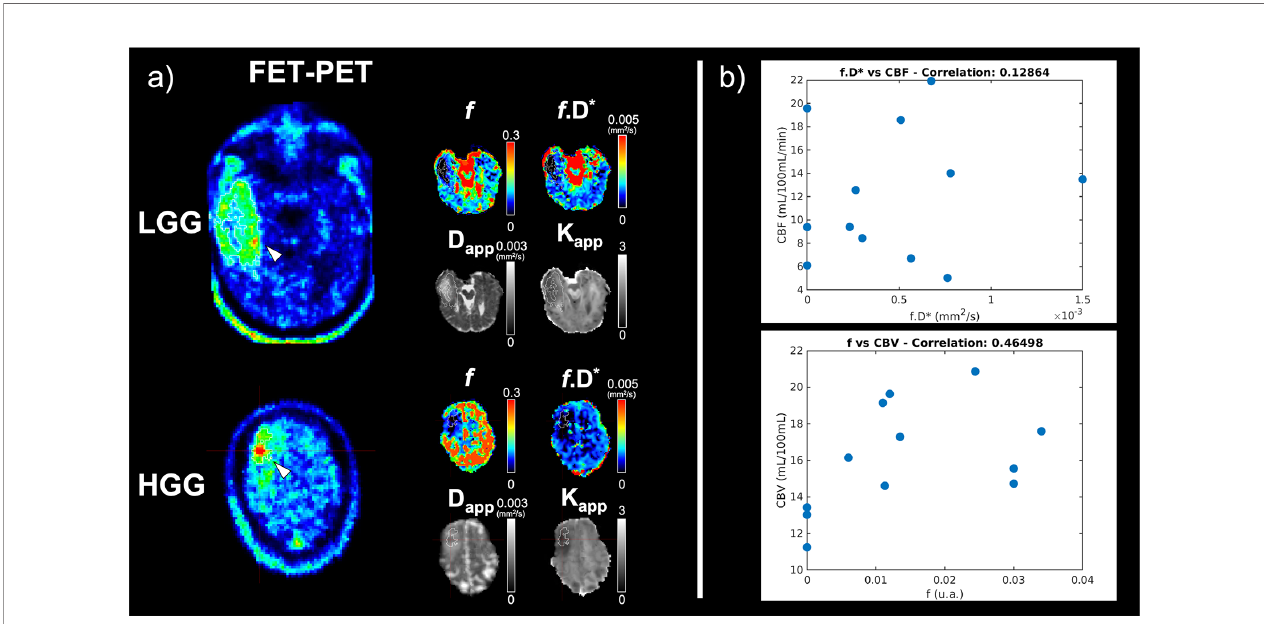
FIGURE 6 | (A) Representative slices of a low-grade glioma (LGG) patient and a high-grade glioma (HGG) patient. FET-PET information is shown on the left and the corresponding slices of the maps from the proposed protocol following the mean neighbourhood fi t are shown beside it. The tumour mask is outined in white. (B) Scatter plots of DSC-derived perfusion parameters cerebral blood volume (CBV) and cerebral blood fl ow (CBF), and the corresponding quantities derived from the present protocol (f and f.D*, respectively). An ROI-based fi tting approach has been used. The size of the tumour ROI is included as a covariae when determining the strength of the